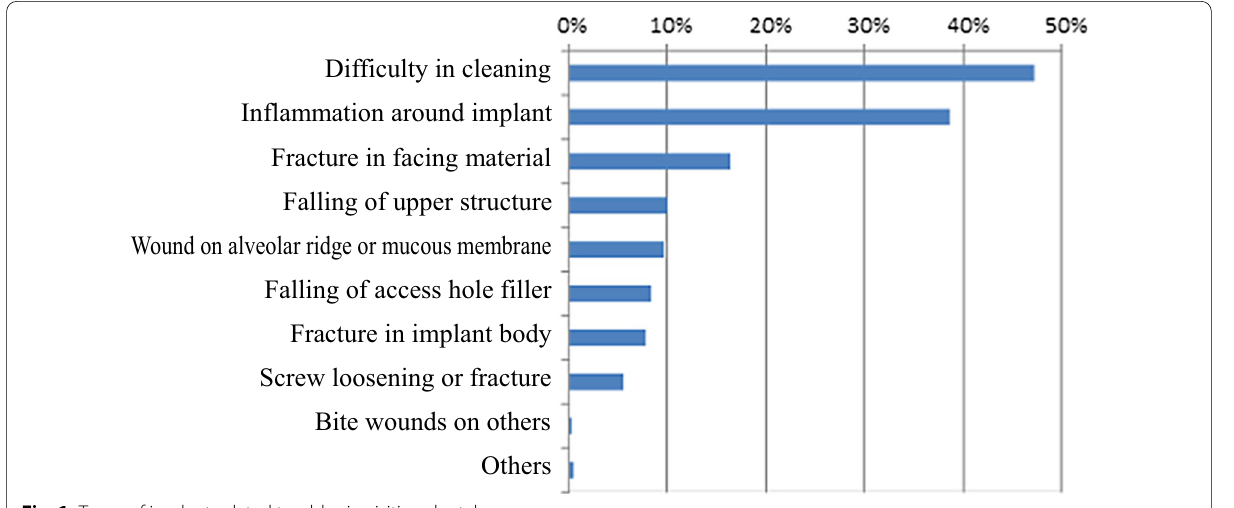
Fig. 1 Types of implant-related troubles in visiting dental care